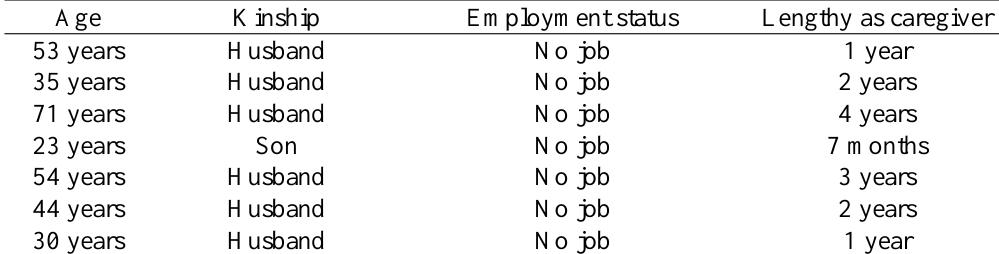
Table 1. Participant demographic